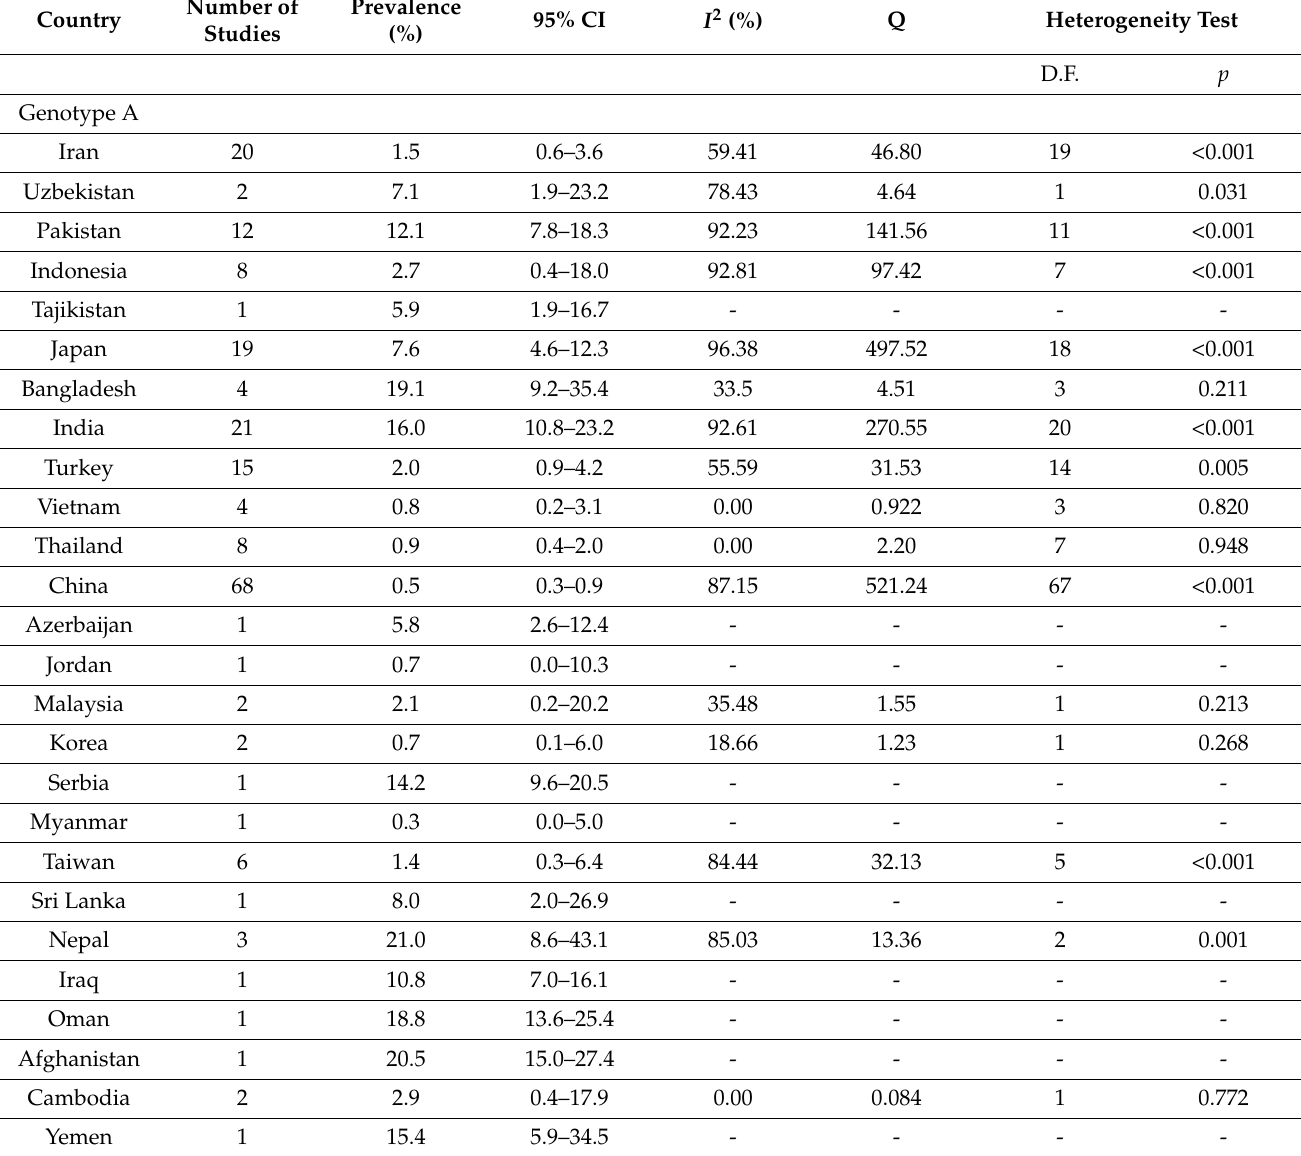
Table 2. Subgroup analysis for comparison of prevalence of HBV genotypes across Asian